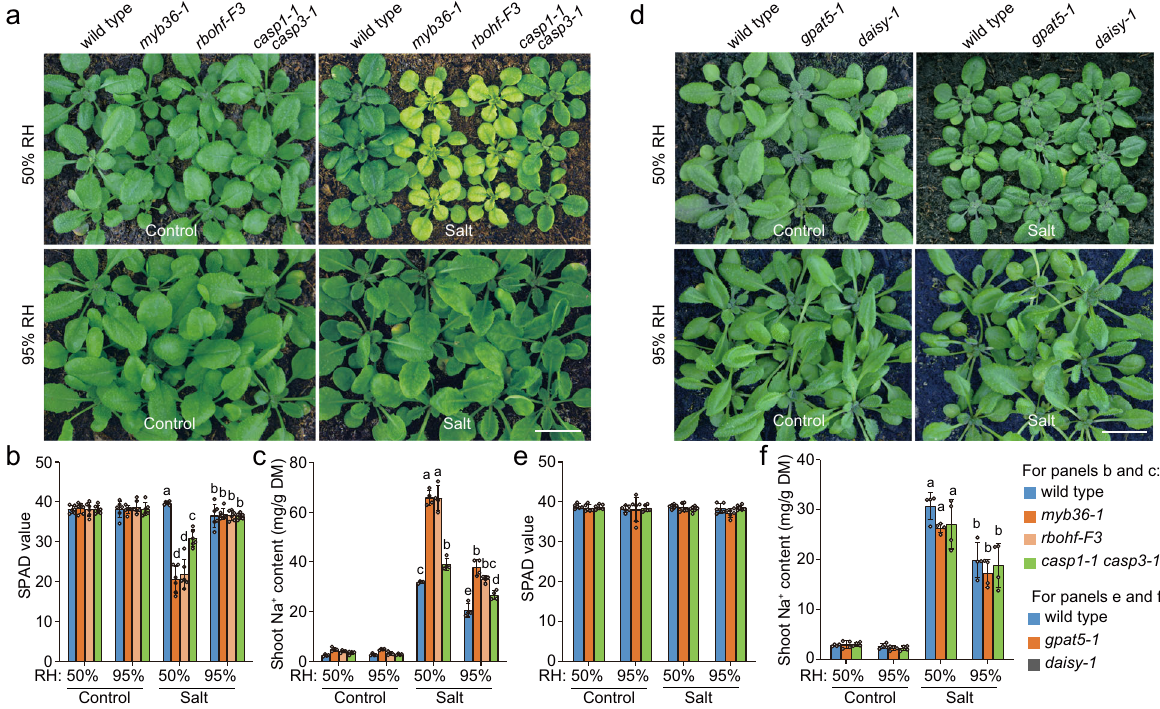
Fig. 7 The lignin deposition at CS domain confers shoot Na + exclusion and salt tolerance in transpiring plants. a – c The appearances ( a ), leaf SPAD values ( b ) and shoot Na + contents ( c ) of myb36-1 , rbohf-F3 , casp1-1 casp3-1 and wild-type plants with indicated treatments. d – f The appearances ( d ), leaf SPAD values ( e ) and shoot Na + contents ( f ) of daisy-1 , gpat5-1 and wild-type plants with the indicated treatments. Plants growth and salt treatment were as described in Fig. 6h – j. The results in ( b , c , e and f ) were means ± s.d. of three independent experiments. Bars in ( a ) and ( d ), 1.0 cm. Source data are provided as a Source Data fi